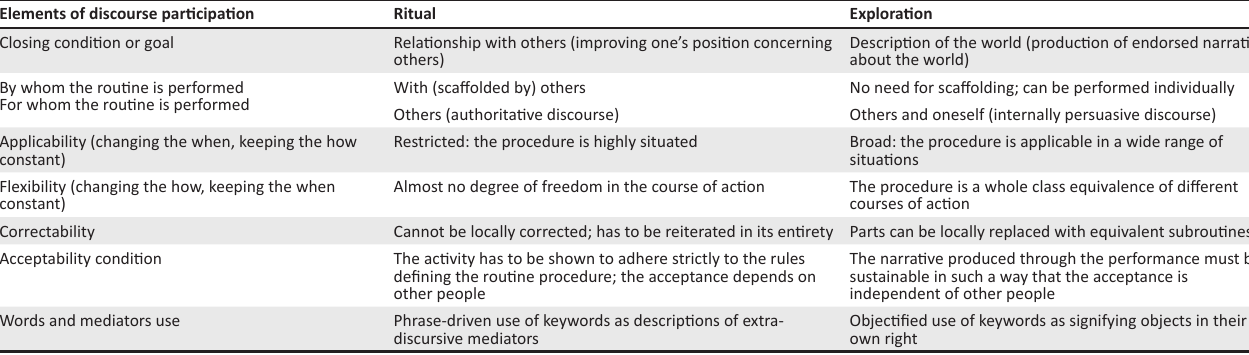
TABLE 1: The comparison between rituals and explorations in commognition. Elements of discourse